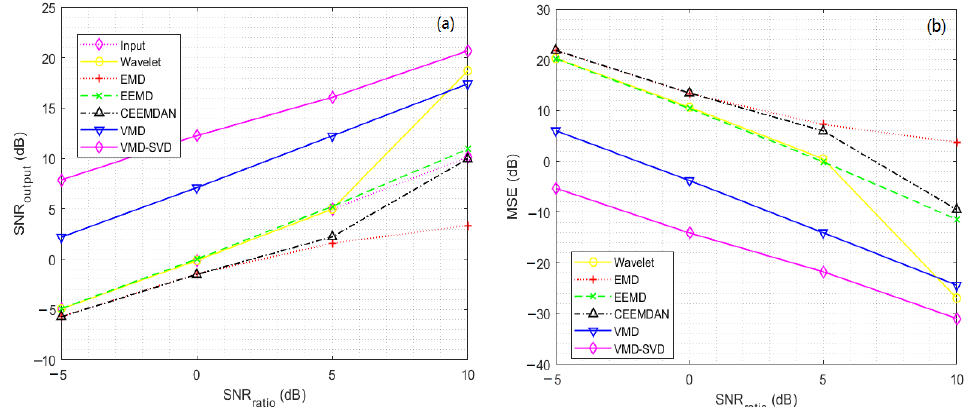
Figure 7. Denoising performance of noisy Bump signals with different SNRs . ( a ) SNRs after noise reduction by various methods with different noise ratios. ( b ) MSEs after noise reduction by various methods with different noise ratios.